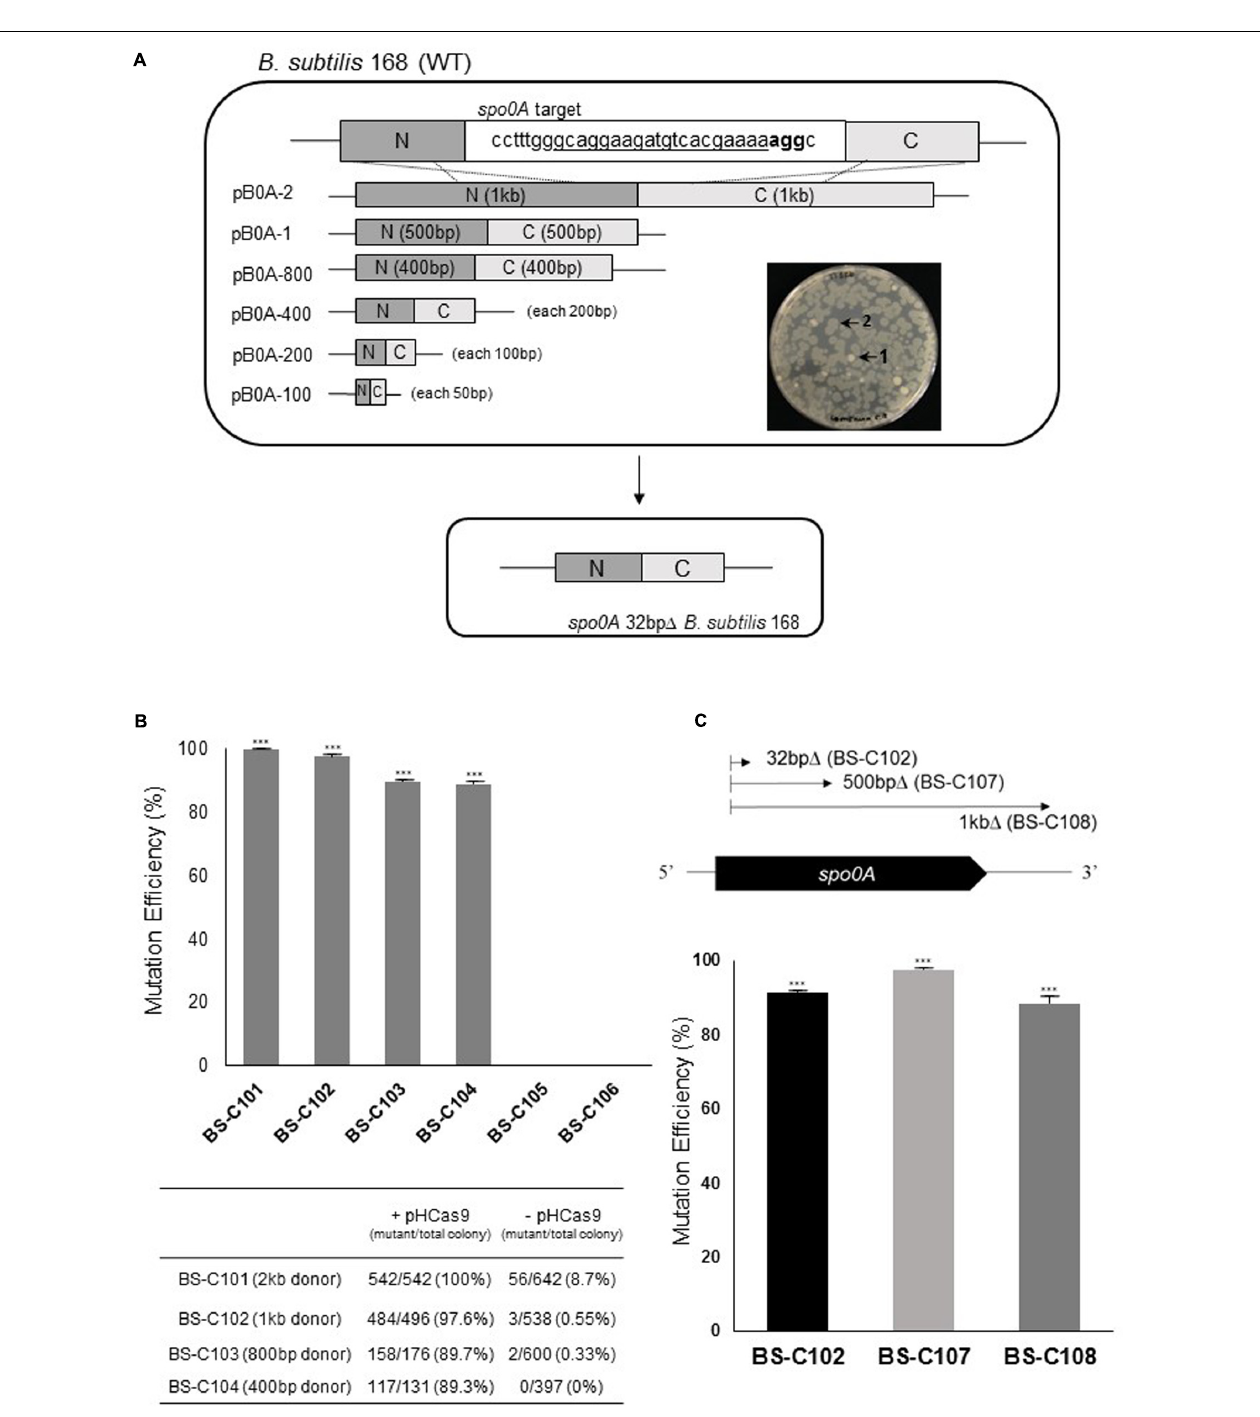
FIGURE 2 | Donor DNA size-dependent HDR in Bacillus subtilis using CRISPR-Cas9. (A) 32 of 804 bp in B. subtilis spo0A were deleted by six different donor DNA templates using homologous recombination. The underlined 20 bp sequence was given as gRNA. Nucleotides shown in bold (agg) are the protospacer adjacent motif (PAM) region. SpCas9-mediated DSB occurred between the 17th adenine (a) and 18th adenine (a) in the gRNA sequence. Significant morphological change (transparent or clear) was observed with spo0A mutant (2) compare to the wild type B. subtilis 168 (1). (B) Mutation efficiencies based on different sizes of donor DNA templates: 2 kb (pB0A-2) to 100 bp (pB0A-100). Means of three independent technical replica experiments are presented; the error bars indicate standard deviations. ∗∗∗ P < 0.001 compared with control without presence of pHCas9. (C) Correlation between mutation efficiency and the size of the deletion region. The HDR-mediated two-plasmids CRISPR-Cas9 system was efficient in generating 32 bp (BS-C102), 500 bp (BS-C107) and 1 kb (BS-C108) deletions in spo0A . Means of three independent technical replica experiments are presented; the error bars indicate standard deviations. ∗∗∗ P < 0.001 compared with control without presence of